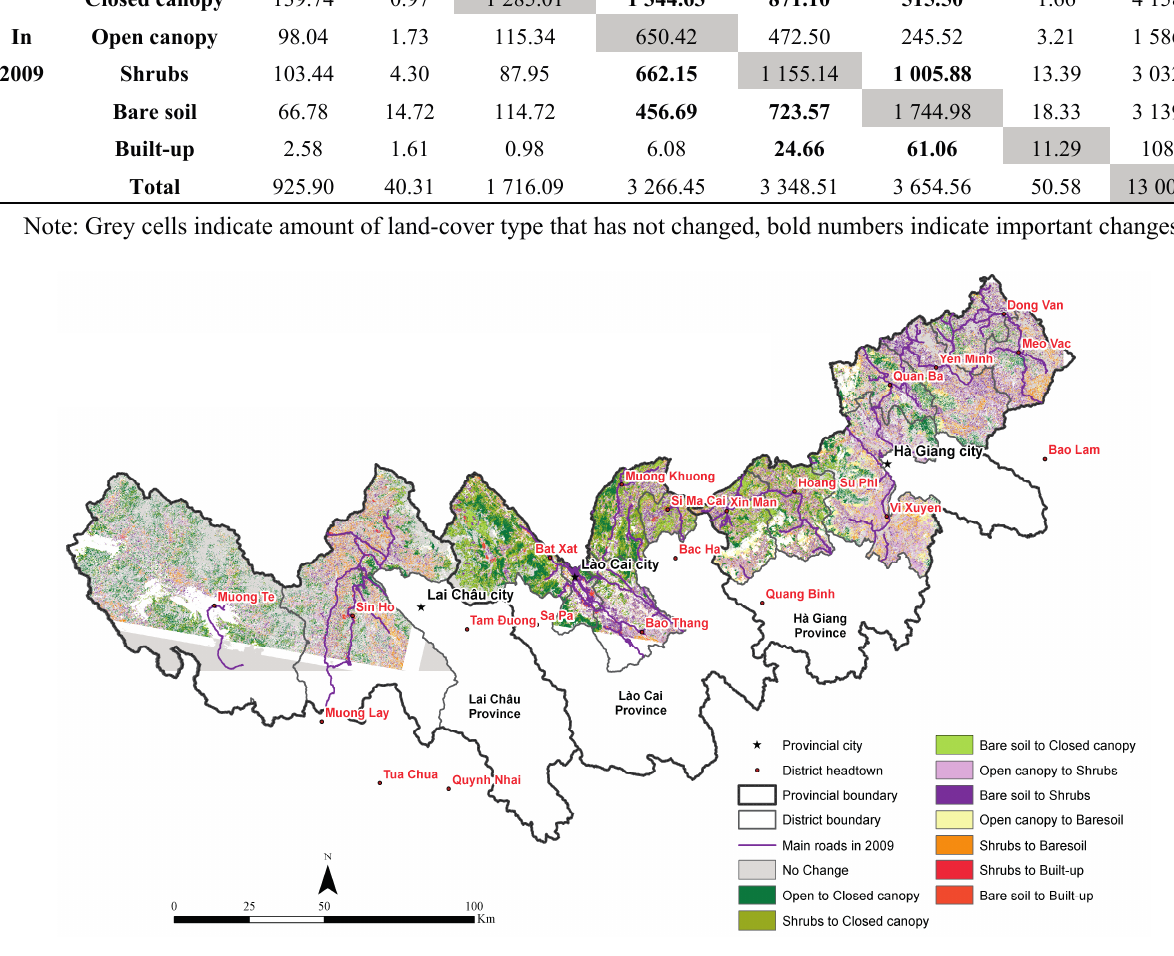
Figure 5. Transitions of land-cover types in the region between 2000 and